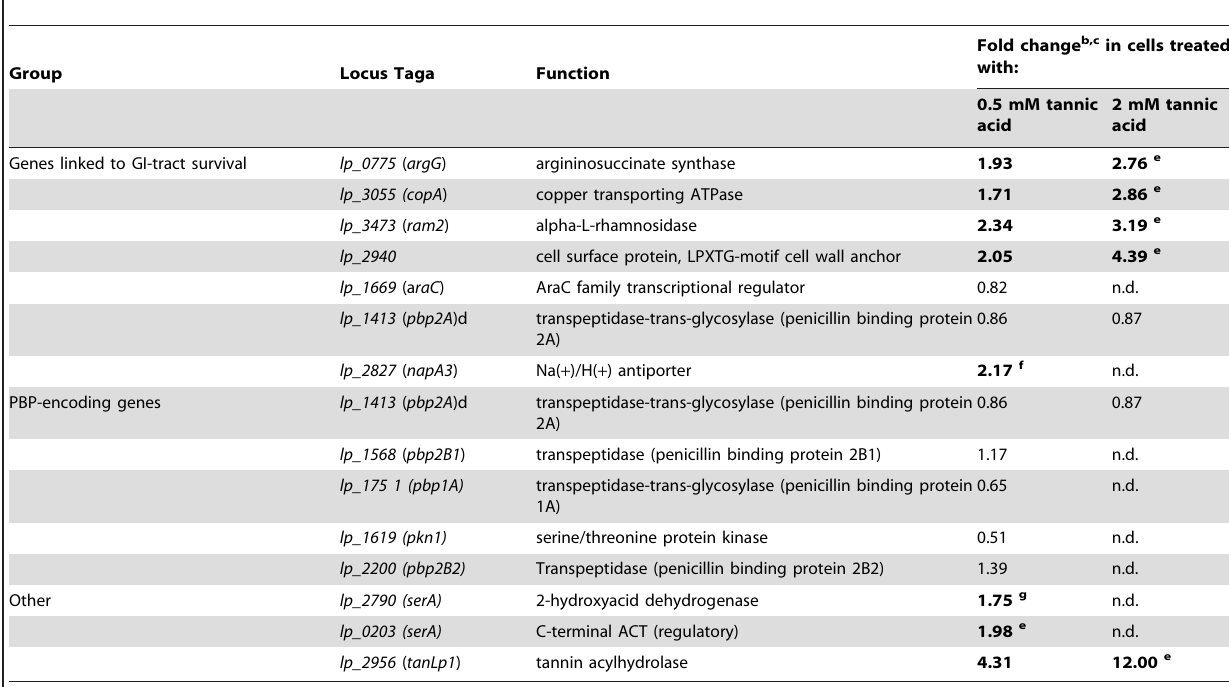
Table 1. Expression of selected L. plantarum WCFS1 genes upon tannic acid challenge.